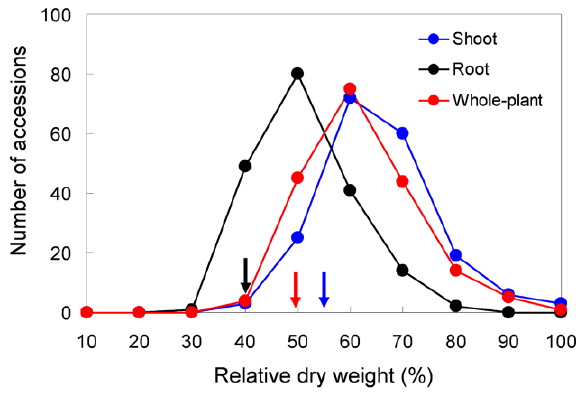
Figure 2. The frequency of relative dry weight of Tibetan barley. The relative dry weight (shoot, root and whole-plant) of 188 accessions was calculated the ratio of the treated (300 mM NaCl) to the control (0 mM NaCl) plants. Arrows indicate the control cultivar, CM72. doi:10.1371/journal.pone.0022938.g002 (Fig. 1). Taking the combined response of Tibetan barley to salinity stress, Salt stress significantly reduced shoot and root dry weight by 27.6% to 73.1% and the root showed greater reductions significant differences between the different Tibetan barley lines.